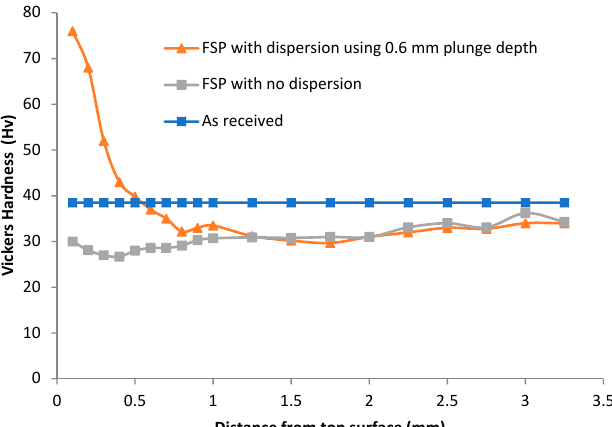
Figure 11. Vickers microhardness through-thickness profile of the FSP aluminum alloy.